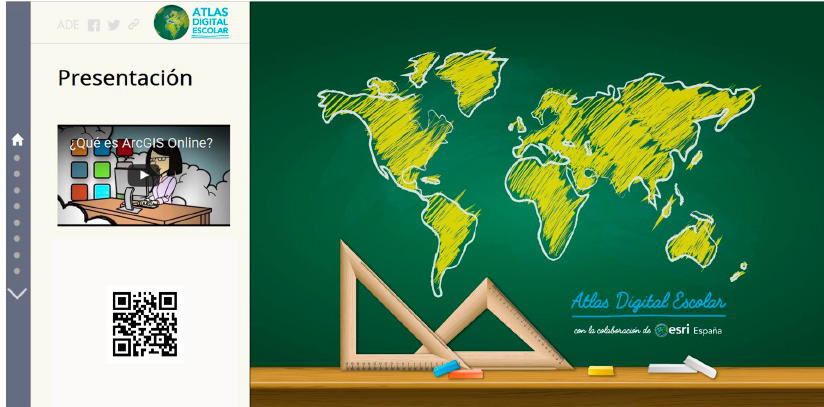
Figure 3. Digital Atlas for Schools front page.